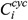
Clustering coefficients in a directed network.Following the definitions in Eq (4) the coefficients (A) Cicyc, (B) Cimid, (C) Ciin and (D) Ciout are shown. For each coefficient two motifs contribute which are indicated by the three large black links and the three small gray links, respectively.